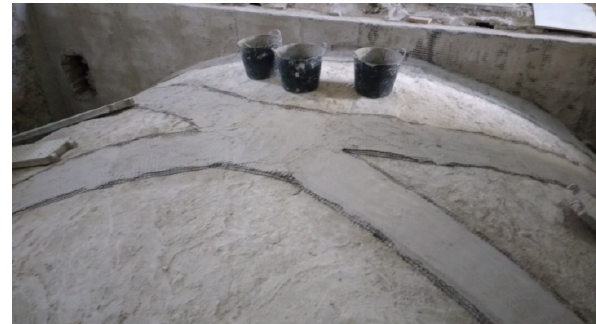
Figure 2: Reinforcement with Planitop HDM and fiberglass Mapei